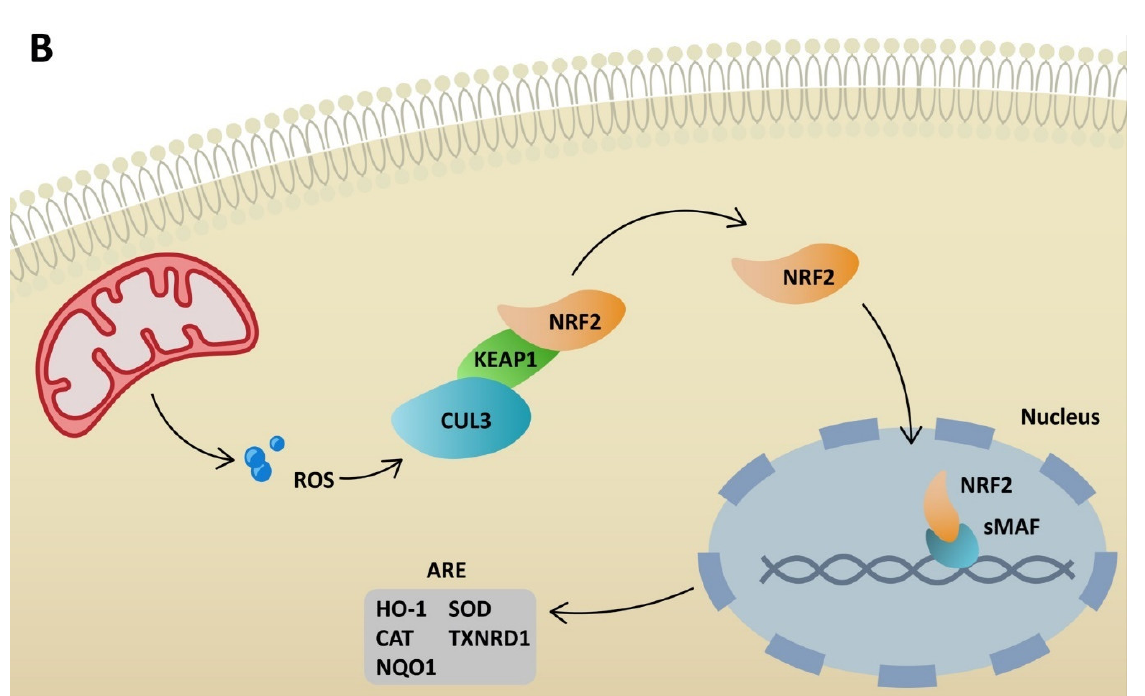
Figure 3. Degradation of NRF2 due to KEAP1 activity ( A ) and activation of antioxidant response elements in stressful conditions by NRF2 ( B ). ROS—reactive oxygen species; CUL3—cullin 3; KEAP1— Kelch-like ECH-associated protein; NRF2—nuclear factor erythroid 2-related factor 2; HO-1—heme